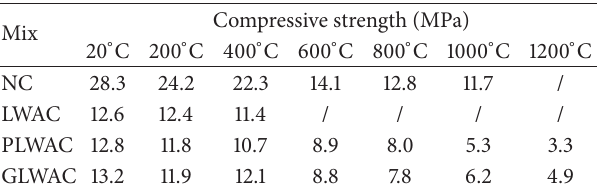
Table 5: Compressive strength of the concrete specimens after exposure to elevated temperatures.